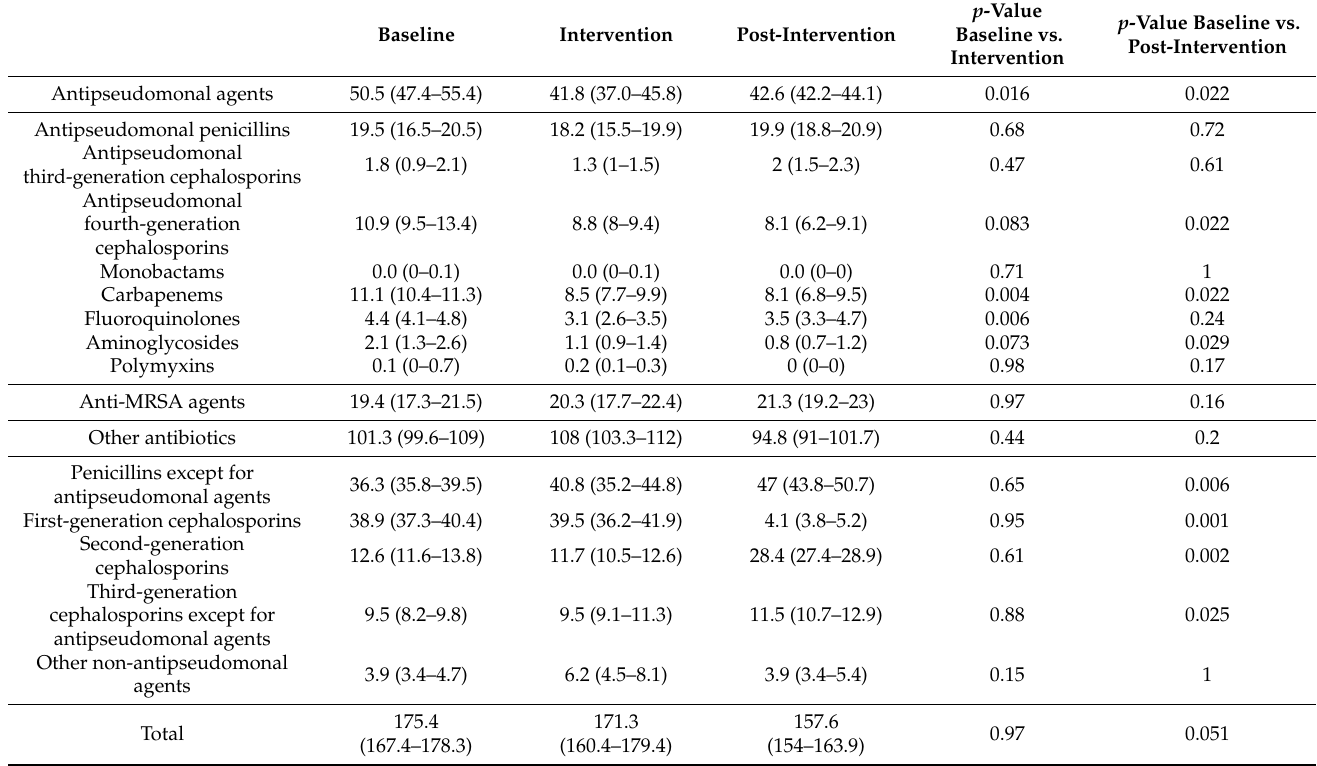
Table 3. Defined Daily Dose (DDD) of antibiotics per 1000 patient-days, median (IQR).